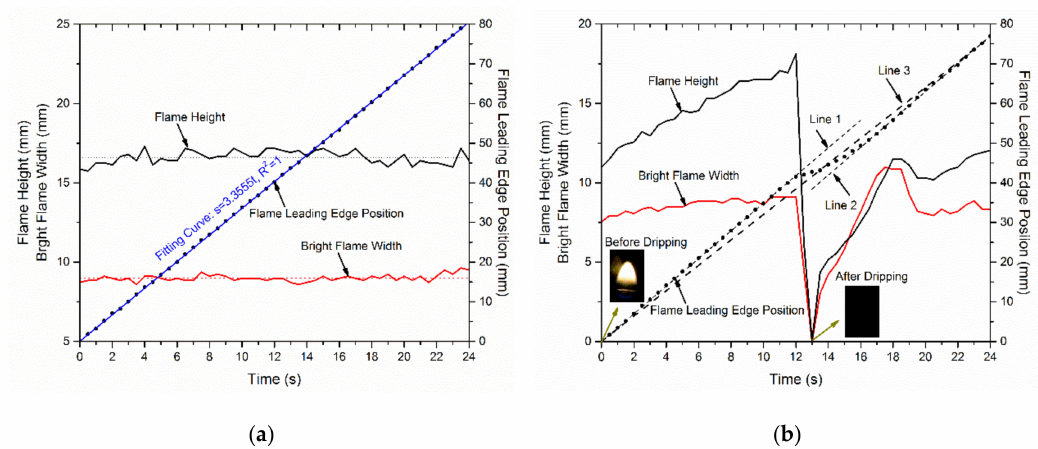
Figure 7. The flame height, the bright flame width and the flame front position for the wire within 24 s at 60.0 kPa. ( a ) I = 4.5 A and ( b ) I = 4.6